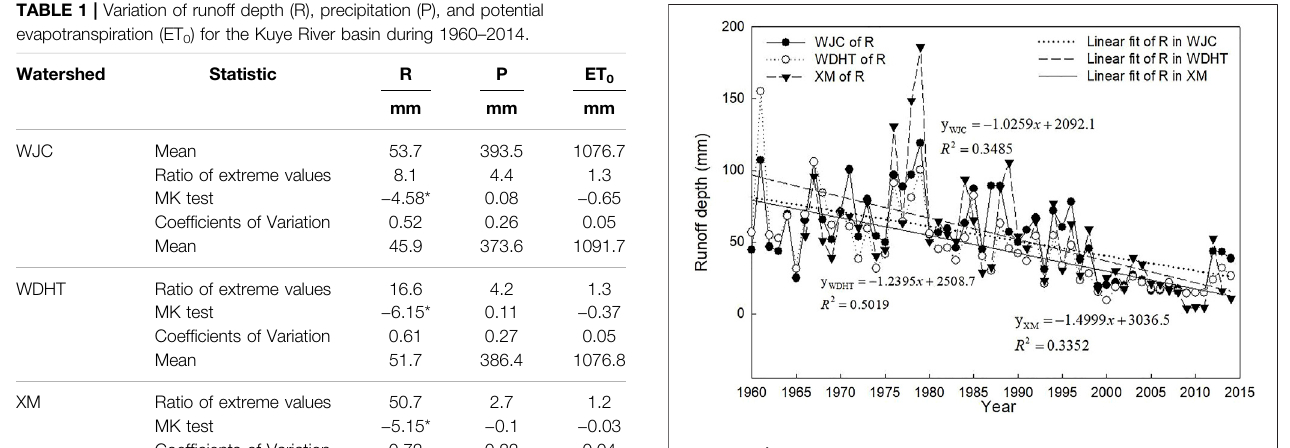
FIGURE3| Thevariationin Rinthe KuyeRiver basin during 1960-2014.